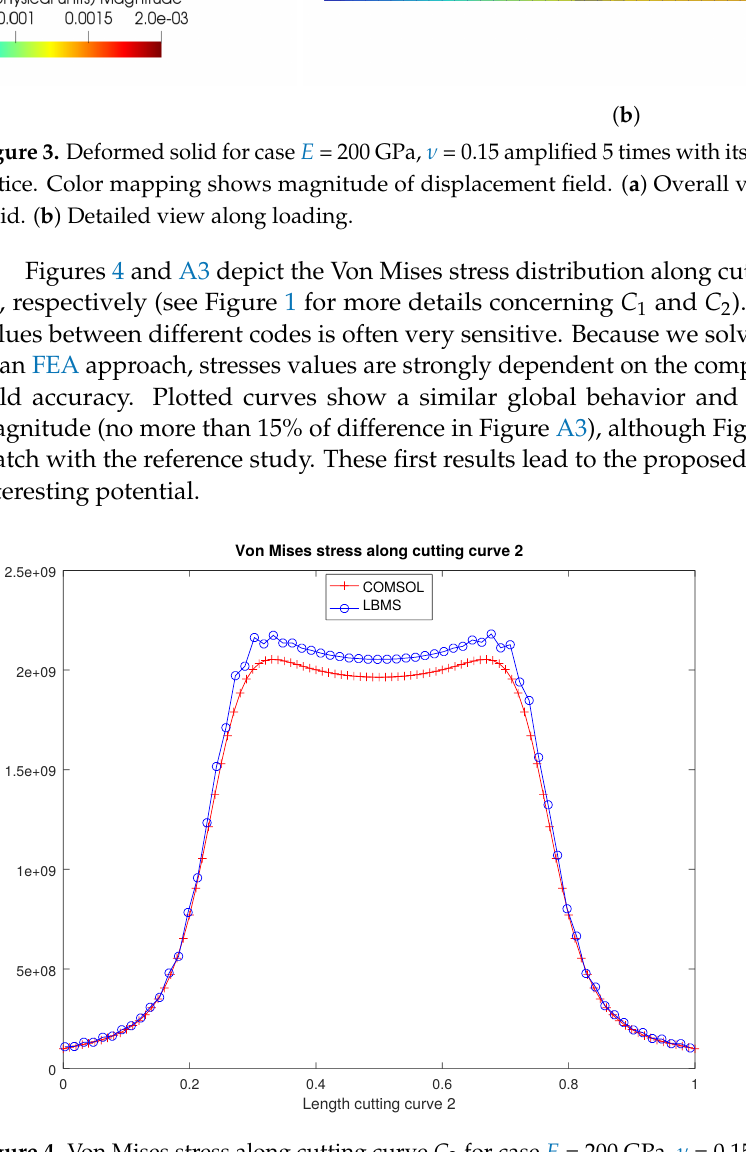
Figure 4. Von Mises stress along cutting curve C 2 for case E = 200 GPa, ν =